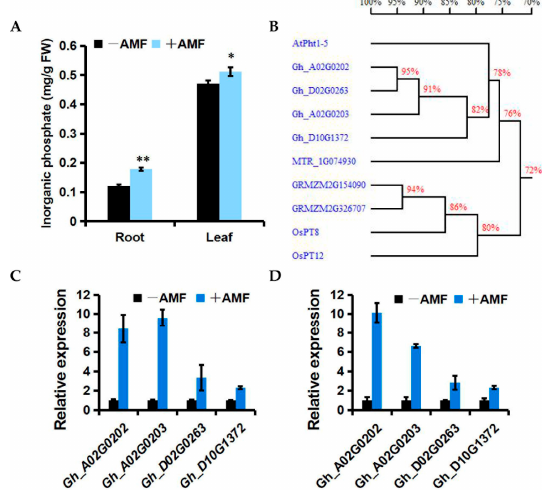
Figure 4. Effects of AMF on inorganic phosphorus (Pi) transport of Lumian 1 at 60 dpi under field conditions. ( A ) Pi content of both the root and leaf. +AMF: mycorrhizal; − AMF: nonmycorrhizal. Error bars represent ±SD. * p < 0.05; ** p < 0.01. ( B ) Homology tree for amino acid sequences of AtPht 1–5 (At2G32830) and its homologs within Gossypium hirsutum (Gh_A02G0202, Gh_A02G0203, Gh_D02G0263 and Gh_D10G1372), Oryza sativa (OsPT8, AAN39049; OsPT12, AAN39053), Zea mays (GRMZM2G326707, GRMZM2G154090) and Medicago truncatula (MTR_1g074930). This was generated by DNAMAN version 5.2.2.0 (Lynnon Biosoft, San Ramon, CA, USA); ( C , D ) Expression level of cotton homologs of AtPht 1–5 in root ( C ) and leaf ( D ). The test performed by quantitative RT-PCR analysis. Transcript abundance of genes was normalized to that of the reference gene UBQ7 (GenBank Accession Number: DQ116441). Three biological replicates were used for each reaction with three technical replicates each. Mean values and standard errors were calculated from three biological replicates.